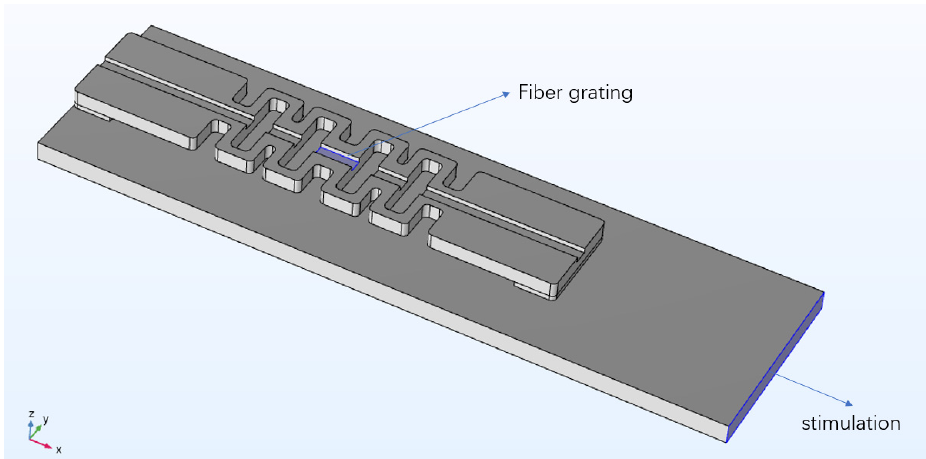
Figure 8. Dynamic excitation loading diagram. The highlighted region represents the stimulation and fiber grating.